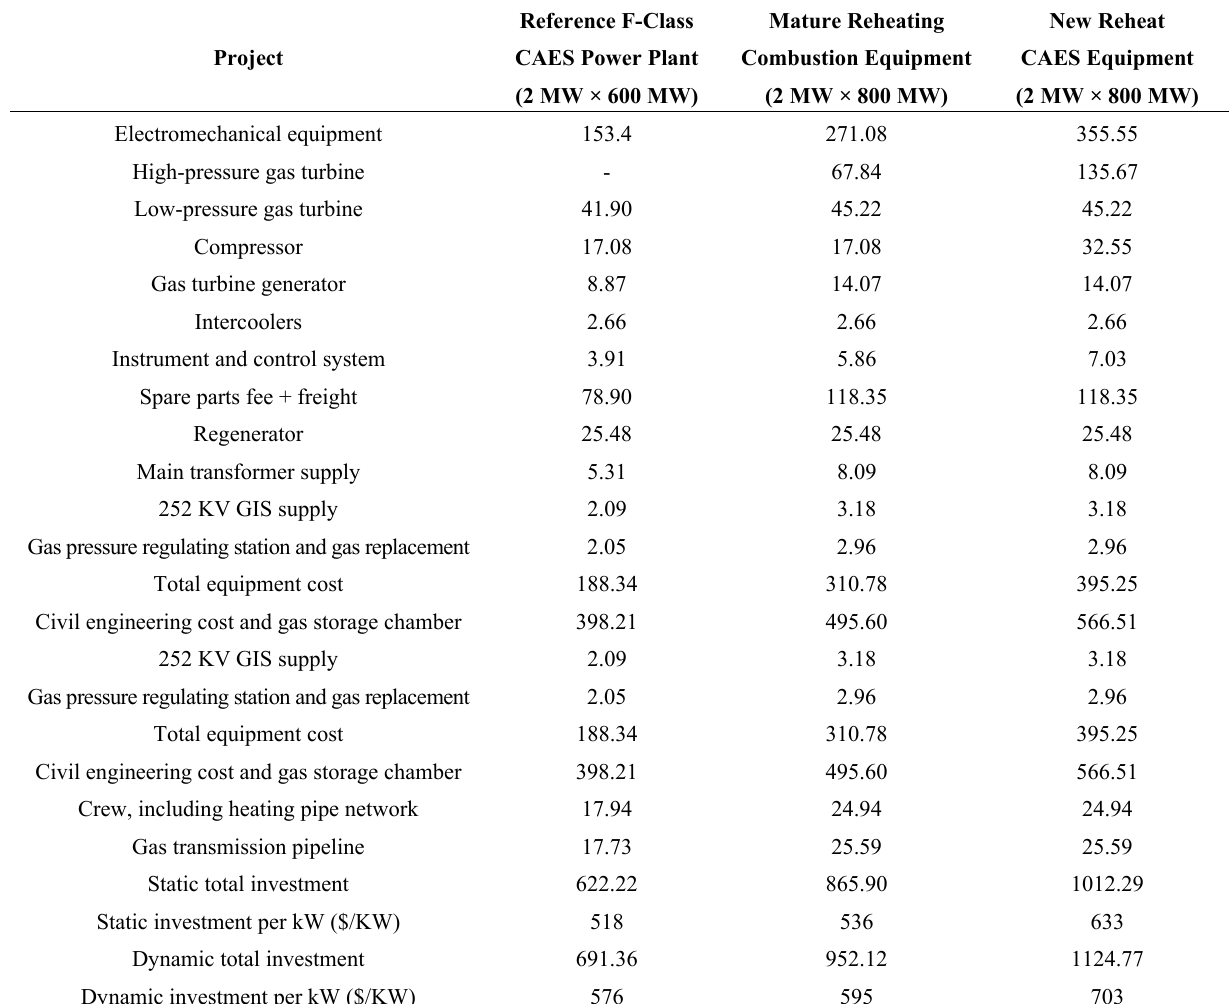
Table 3. Investment estimation (million